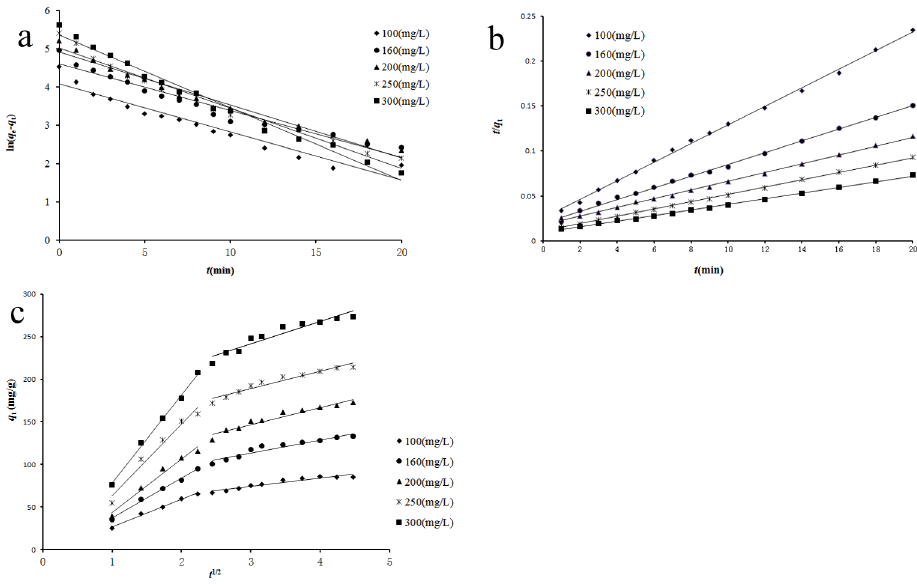
Fig 6. Regressions of kinetics plots at different initial reserpine concentration. (experimental conditions: T = 303 K, pH = 5, c 0 = 100~300 mg/L and absorbent dosage = 0.10g). (a) pseudo-first-order; (b) pseudo-second-order; (c) intra-particle diffusion.